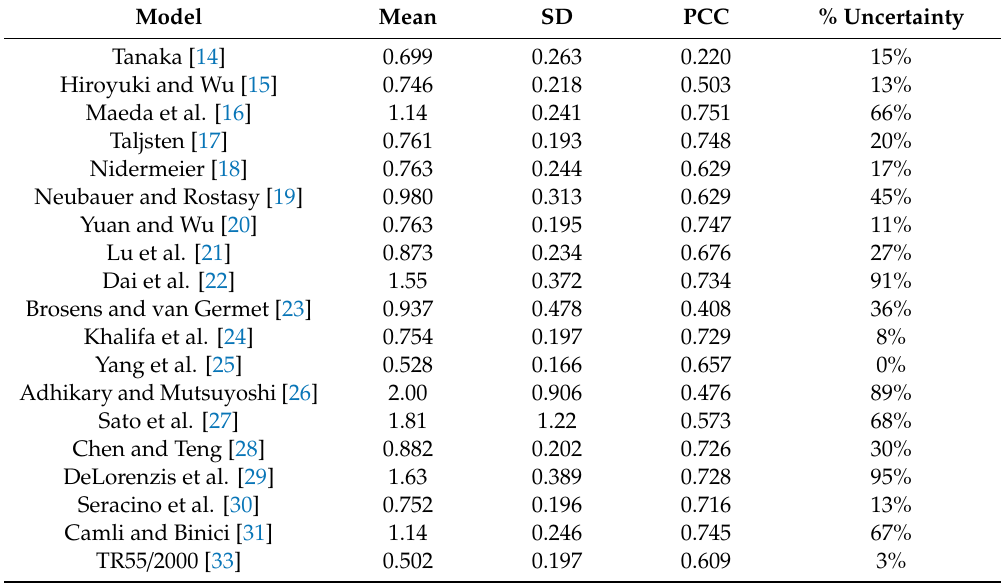
Table 4. Summary of results—predicted to experimental bond strength ratios for steel-reinforced polymer (SRP) composites bonded to